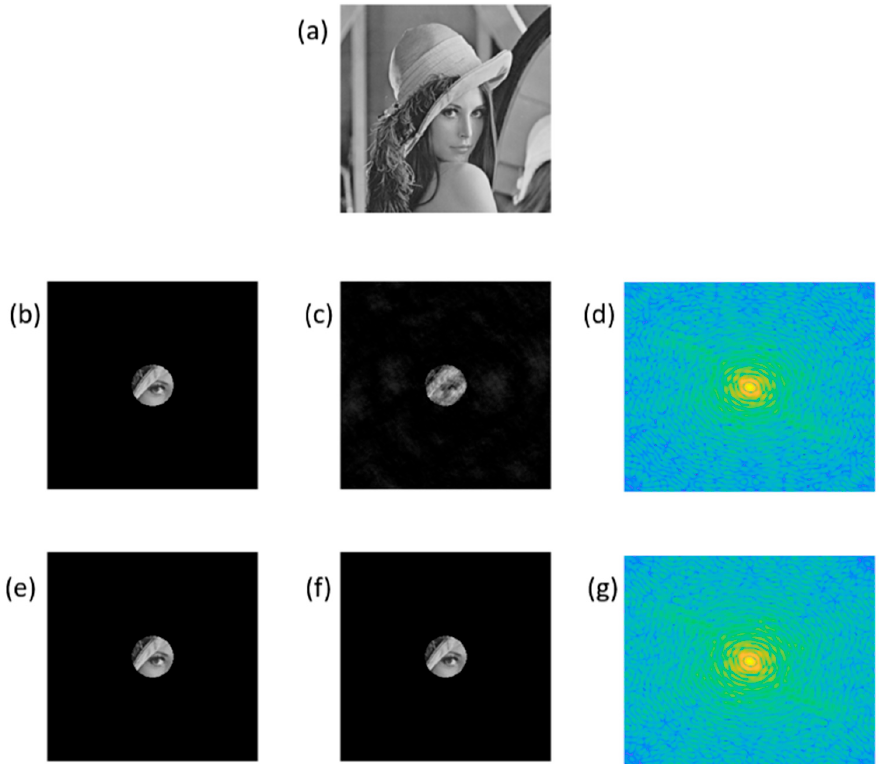
Figure 6. ( a ) Lena image as the test specimen for simulation; ( b ) exit wave from Gaussian illumination; ( c ) reconstruction using Gaussian illumination; ( d ) diffraction pattern from ( b ); ( e ) exit wave from top-hat illumination; ( f ) reconstruction using top-hat illumination; and ( g ) diffraction pattern from ( e ).